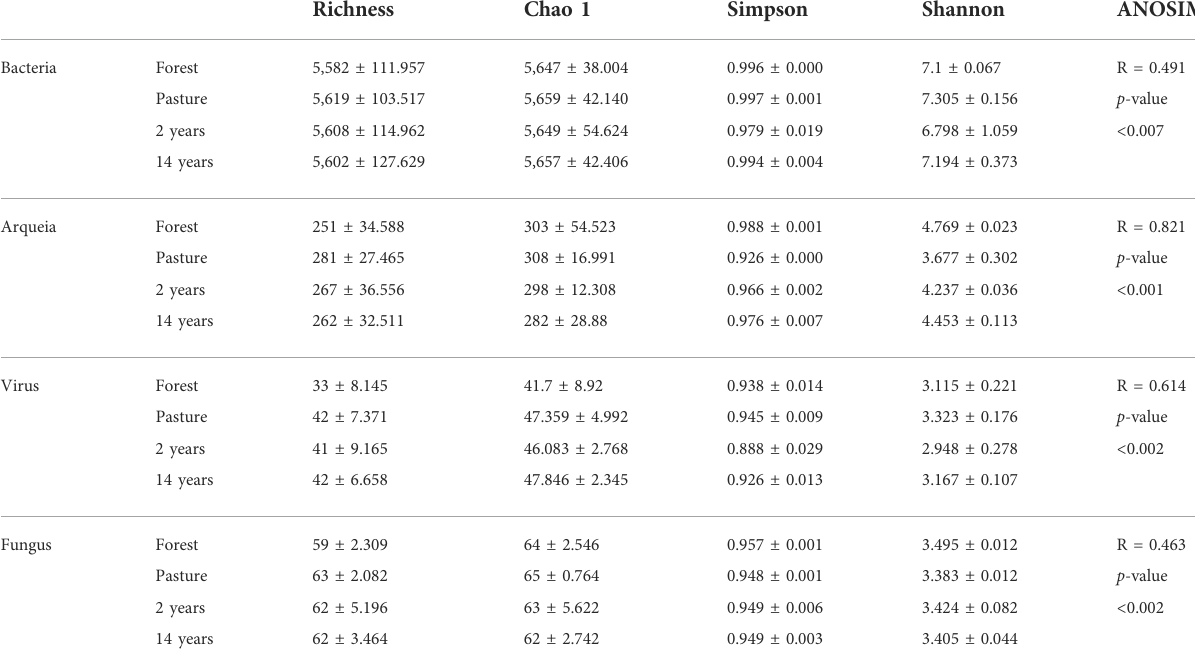
TABLE 3 Alpha and beta diversity indices in the different organisms identi fi ed in the